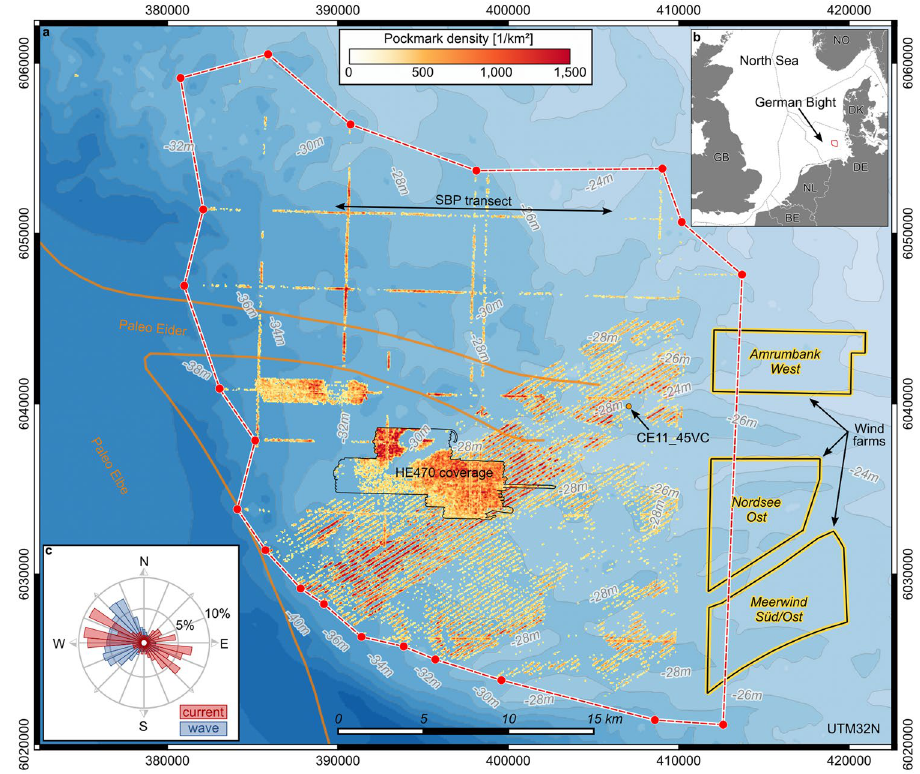
Figure 1. The Helgoland Reef pockmark field. ( a ) Extent of the field and pockmark density in relation to the course of the Paleo Eider and Paleo Elbe valley 29 . The location of the sub-bottom profiler (SBP) transect and location of core CE11_45VC from Fig. 4 are indicated. ( b ) Location of the Helgoland Reef pockmark field in the North Sea. ( c ) Histogram of the hydrodynamic climate at Helgoland Reef. The data were provided by